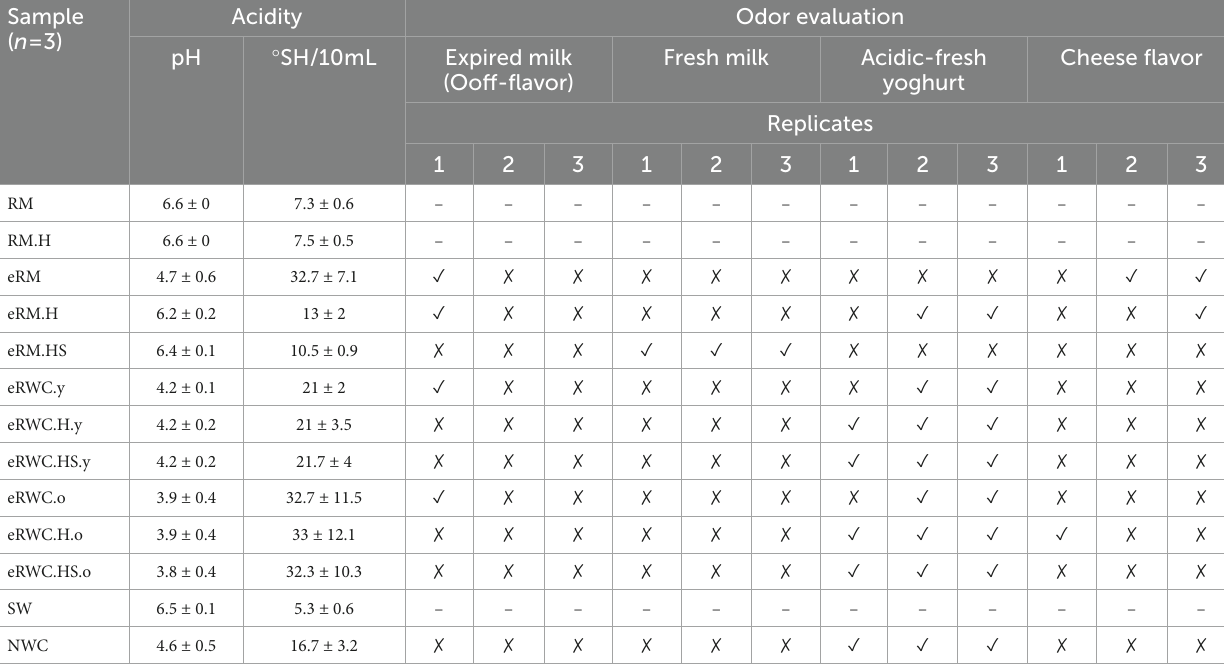
TABLE 1 Acidity and odor evaluation of RM, RM.H, eRMs, NWC, SW, and eRWCs. Sample ( n =